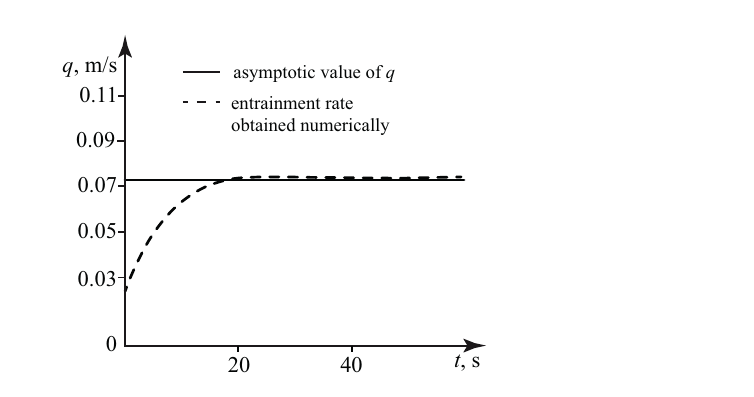
Figure 15. Comparison of the entrainment rate obtained numerically (dashed line) with the asymptotic value q as (solid line) for the Herschel–Bulkley fluid with the parameters (54); τ c = 1.2 × 10 3 Pa, ψ = 30 ◦